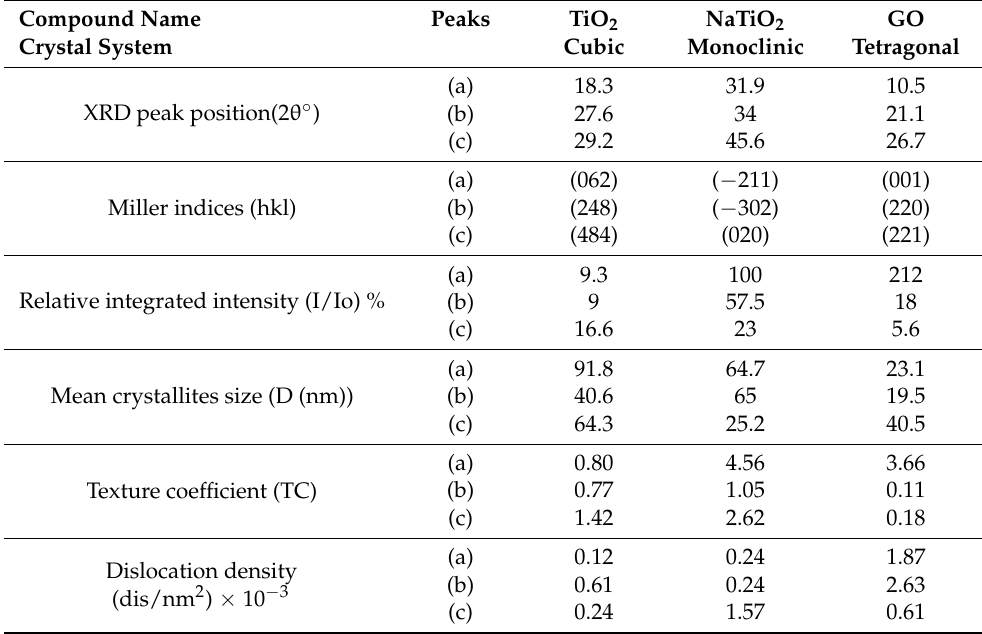
Table 3. The structural parameters of TiO 2 , NaTiO 2 , and